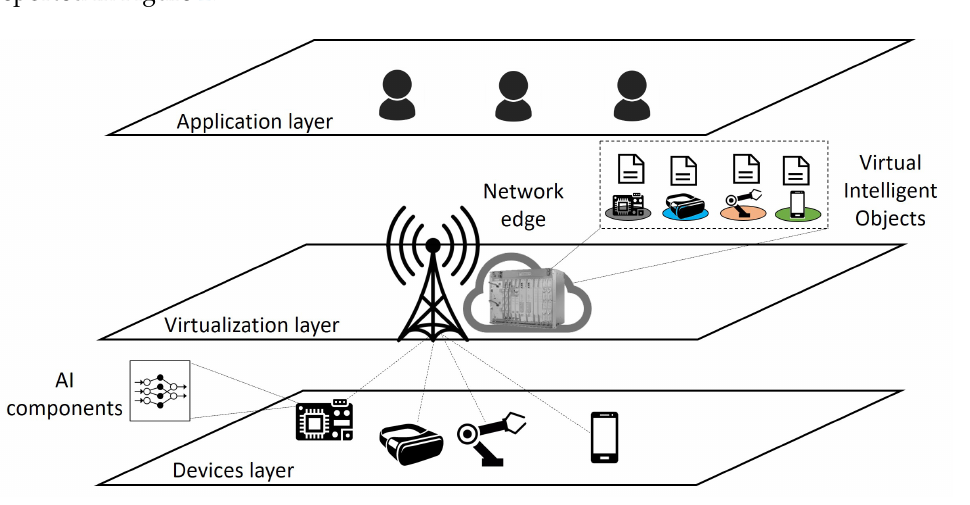
Figure 2. Reference